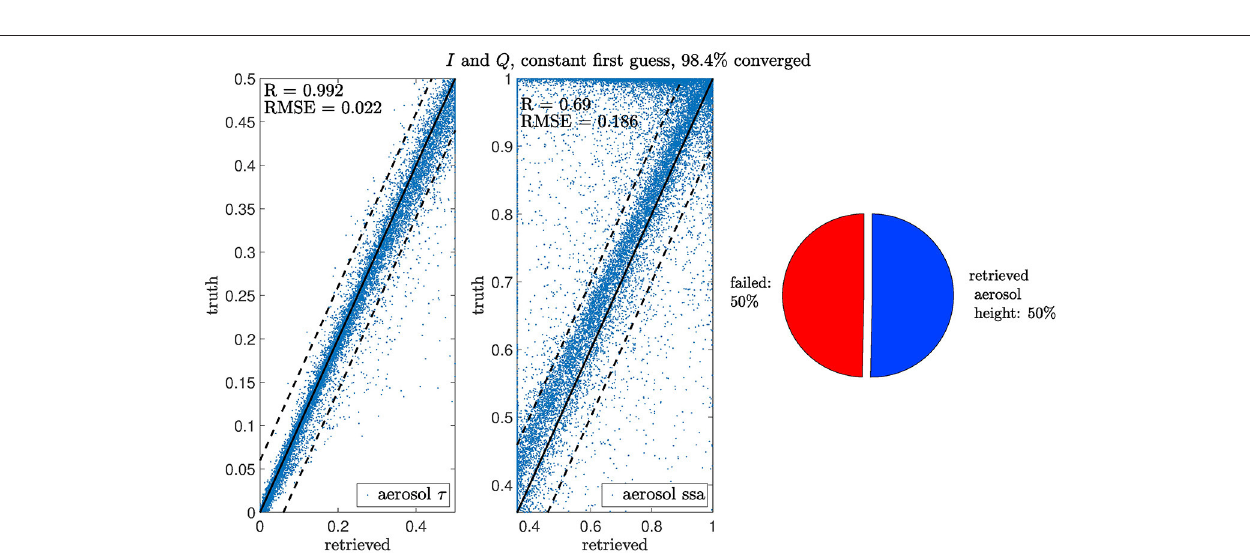
FIGURE 4 | Benchmark retrieval: A synthetic optimal estimation based retrieval of aerosol optical depth at 869 nm and the fraction of absorbing aerosols for MODIS assuming the instrument could measure the Q Stokes parameter in addition to I in nine VIS channels. This retrieval uses the I and Q measurements, and a neural network based first guess using direct inversion. This retrieval is used as a best-case scenario and is considered the benchmark for the other scenarios.